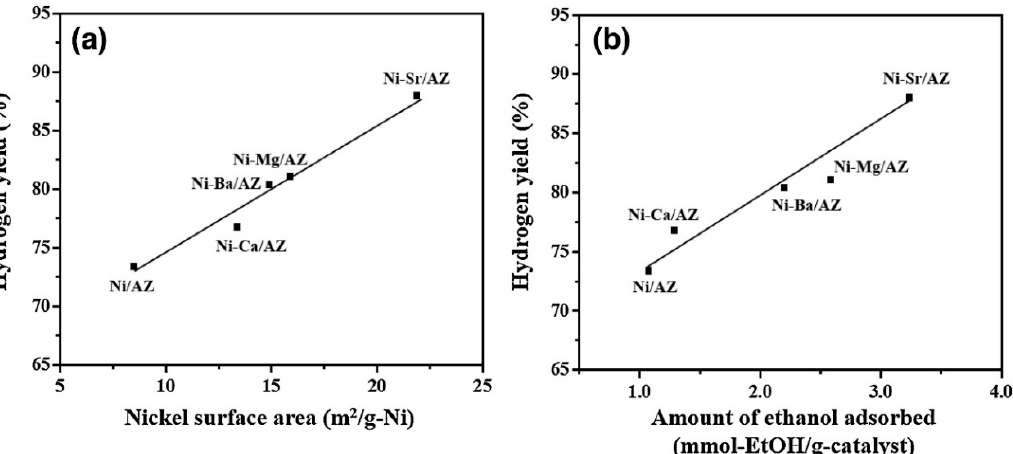
Figure 9. Relationship between the H 2 yield obtained over Ni-X/Al 2 O 3 -ZrO 2 (X = Ba, Ca, Mg and Sr) and their ( a ) nickel surface area and ( b ) ethanol adsorption capacity. Reprinted with permission from Ref. [106]. Copyright 2022 Elsevier.